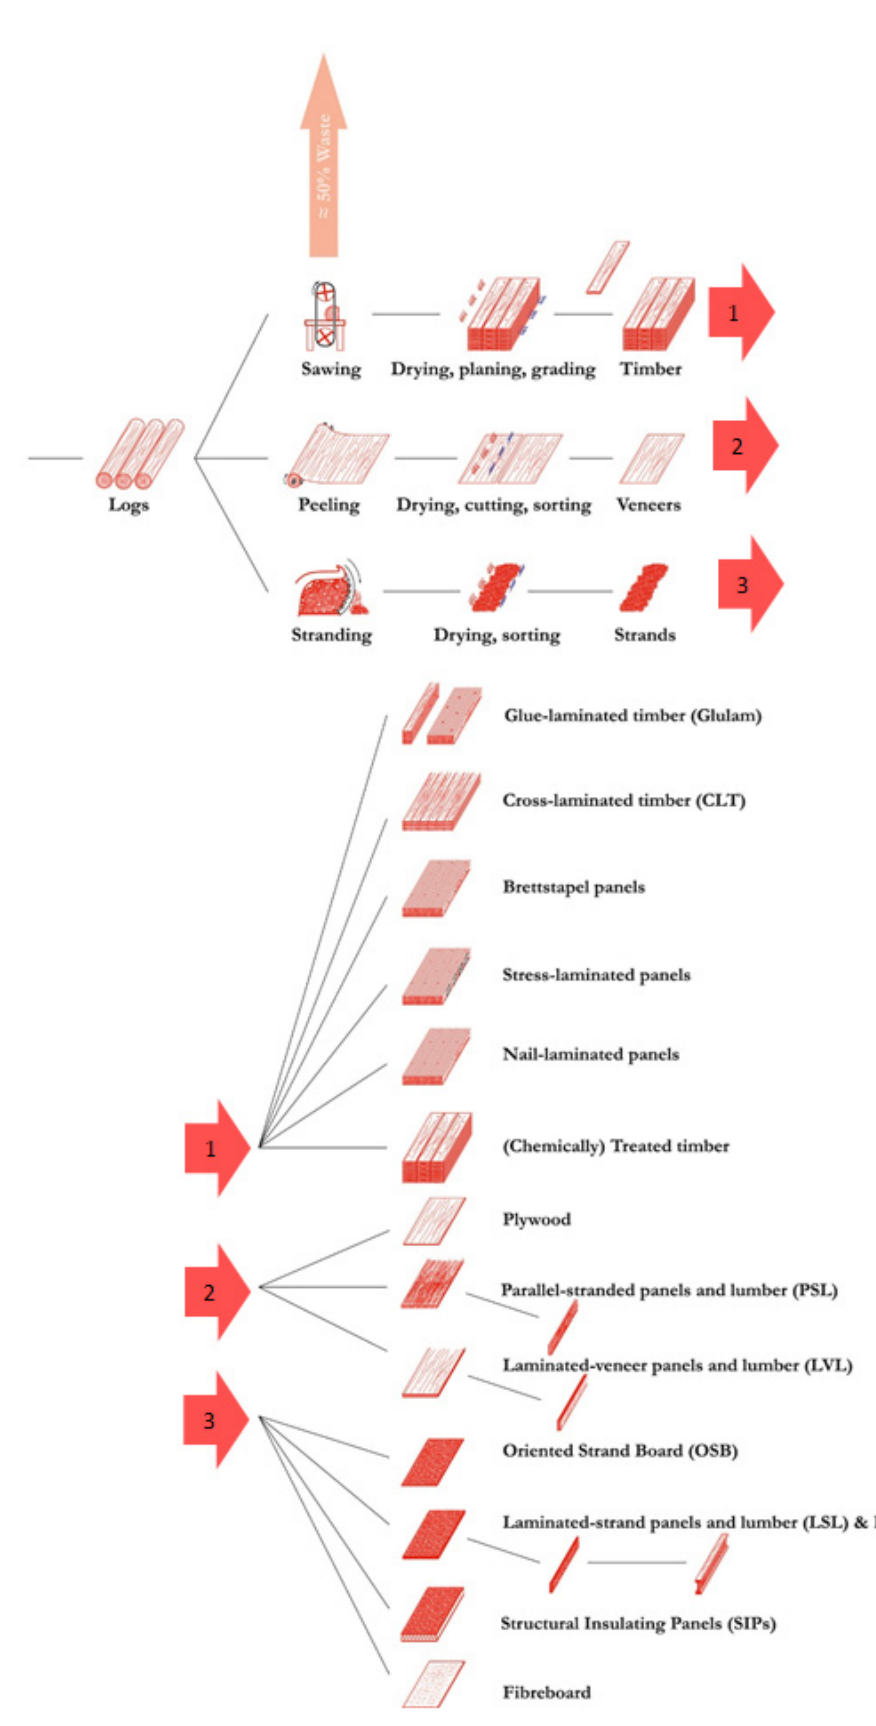
Figure 4. The wood products processing chain P.H. Fleming [90].